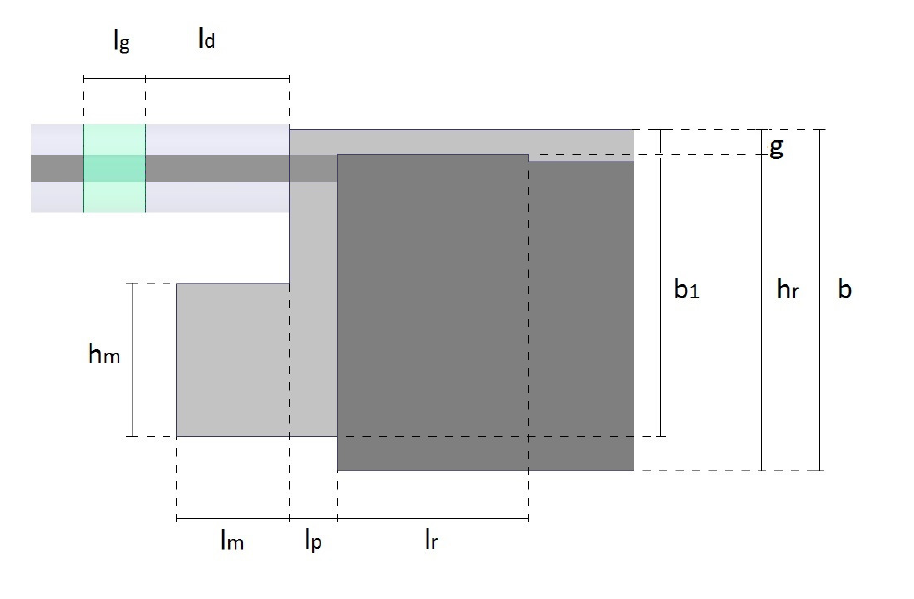
Figure 2. Geometry of the coaxial-to-waveguide transition: sectional lateral view. The pin l p long is shorted on a ridge h r high and l r long (in dark grey). The unridged WG step has a reduced height b 1 , and a matching cavity of dimensions (h m × l m ) is added along the backshort to improve the matching. The coaxial step highlighted in green indicates the l g long air gap inserted at a distance l d from the transition.